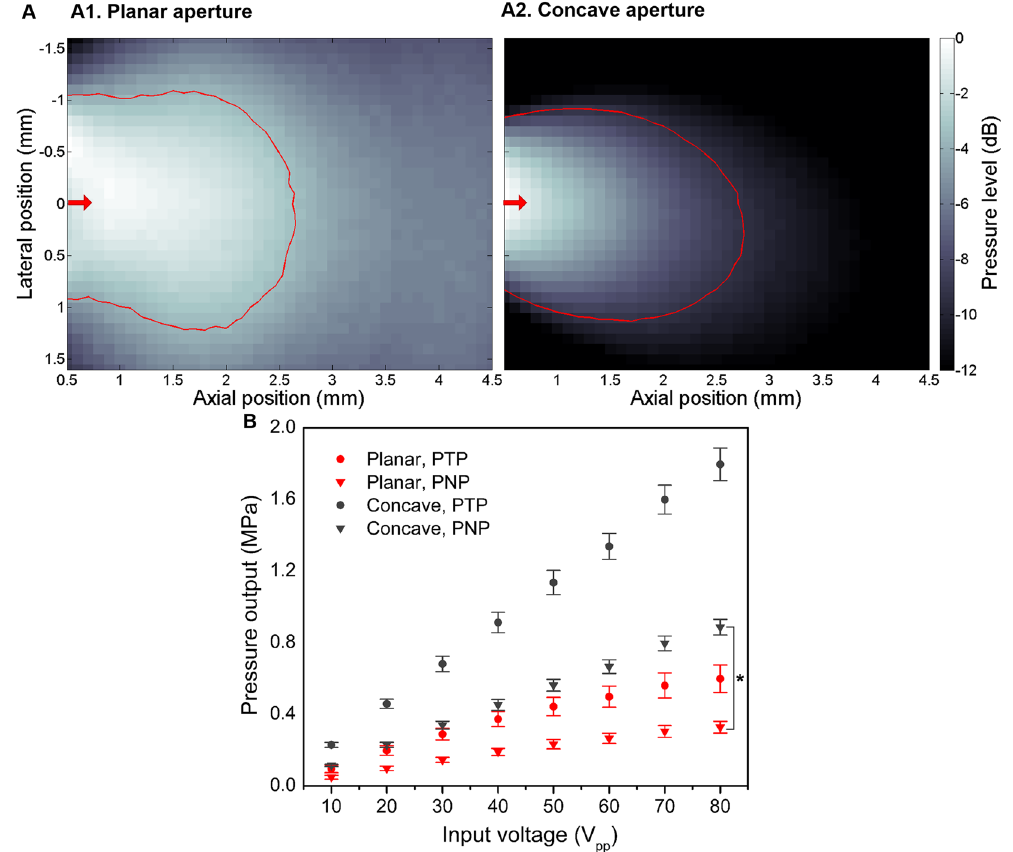
Figure 2. Acoustic characterization of customized stacked-type intravascular ultrasound transducer. ( A ) Measured beam profiles of planar- (A1) and concave-aperture (A2) prototypes; the red arrows indicate the radiation direction, and the red contour lines denote the mechanical index of 0.3 with voltage input of 80 V pp which implies the approximated threshold of inertial cavitation of microbubbles. − 6 dB beam diameters of planar- and concave-aperture prototypes are 3.1 mm and 1.3 mm, respectively. ( B ) Measured pressure output (1 mm away from the aperture) with voltage inputs of 10–80 V pp (n = 2). The concave aperture prototype exhibits approximately 2.5-fold increase in peak-to-peak pressure (PTP) and 2.3-fold increased peak-negative- pressure (PNP) relative to the planar aperture prototype. ( * P <